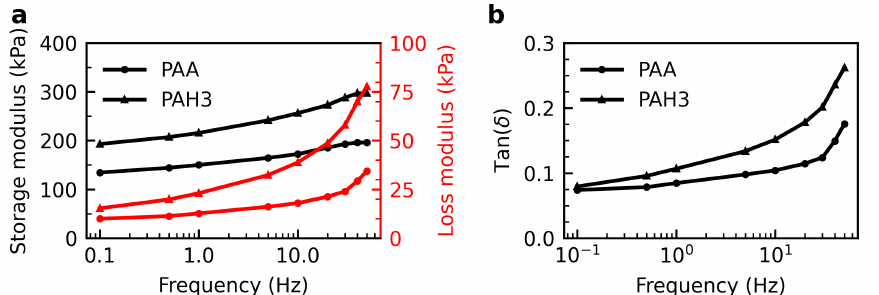
Figure 5. Dynamic mechanical analysis of the PAA and hybird (PAH3, 14 wt%) hydrogels under frequency sweep: ( a ) storage and loss moduli, and ( b ) loss factor tan( δ